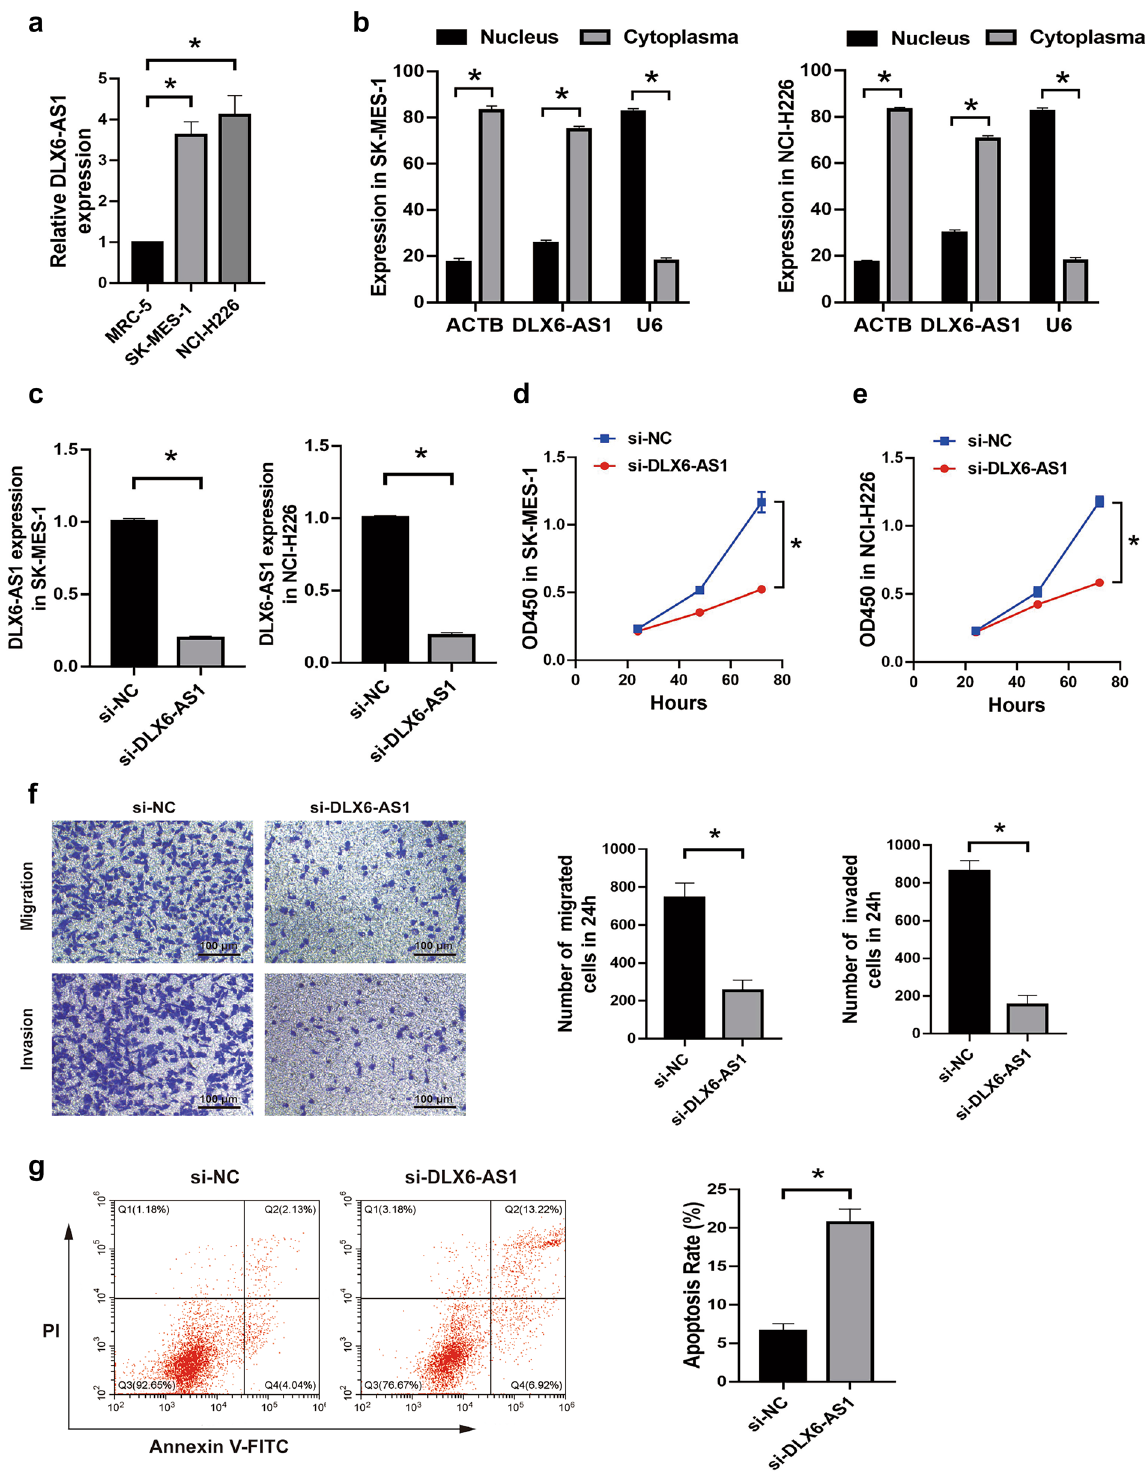
Figure 2. DLX6-AS1 knockdown inhibited proliferation, migration, invasion and promoted apoptosis of LUSC cells. ( a ) qRT-PCR analysis for the relative expression of DLX6-AS1 in SK-MES-1, NCI-H226, and MRC-5 cell lines. ( b ) qRT-PCR analysis for the relative expression of DLX6-AS1 in the cytoplasm or nucleus of SK-MES-1 and NCI-H226 cell lines. ( c ) The relative expression of DLX6-AS1 transfected with si-DLX6-AS1 or si-NC in SK-MES-1 and NCI-H226 cell lines was estimated by qRT-PCR analysis. ( d,e ) CCK-8 assay was performed to detect the proliferation of SK-MES-1 ( d ) and NCI-H226 ( e ) cells transfected with si-DLX6-AS1 or si-NC. ( f ) Transwell analysis of SK-MES-1 cells transfected with si-DLX6-AS1 or si-NC. ( g ) Apoptotic rate of SK-MES-1 cells transfected with si-DLX6-AS1 or si-NC. * P <